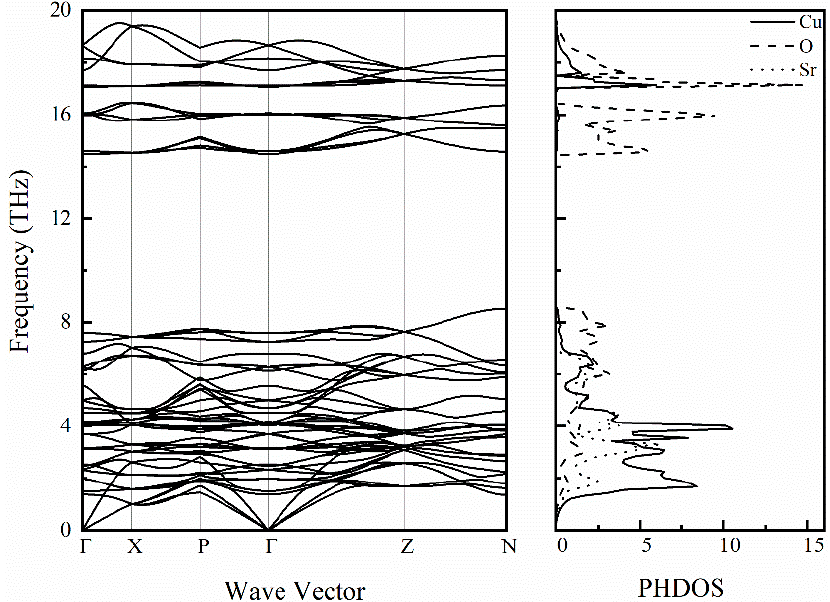
Figure 8. Calculated phonon spectrum and the corresponding phonon density of states for SrCu 2 O 2 .